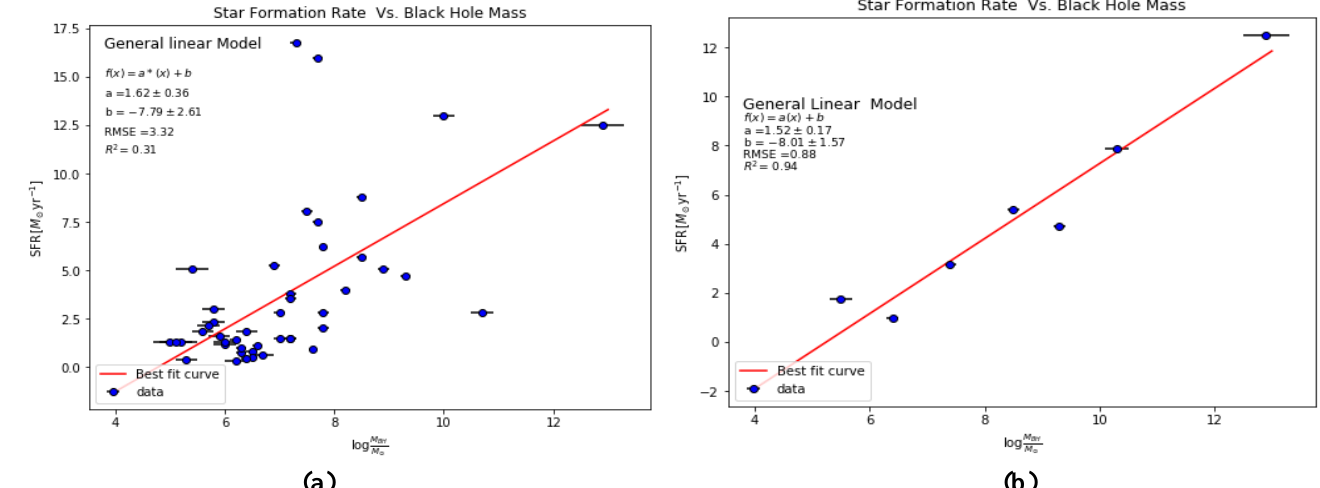
Fig.3: The correlation between the SMBH & SFR for seyfert 1 galaxies using linear regression, where (a) for all samples, (b) median data.